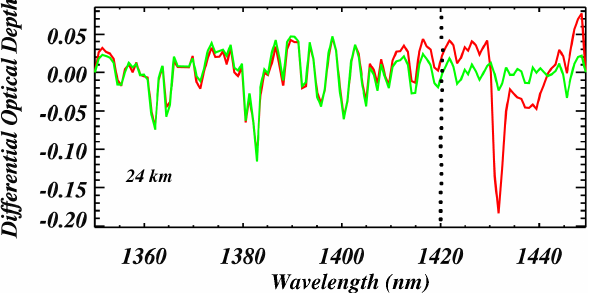
Fig. 6. Residual plot for the selected wavelength window 1350– 1420nm (corresponds to the same measurement as for Fig. 5): The residuals signify the difference between the measured and the simu- lated differential transmitted spectra. The residuals are about